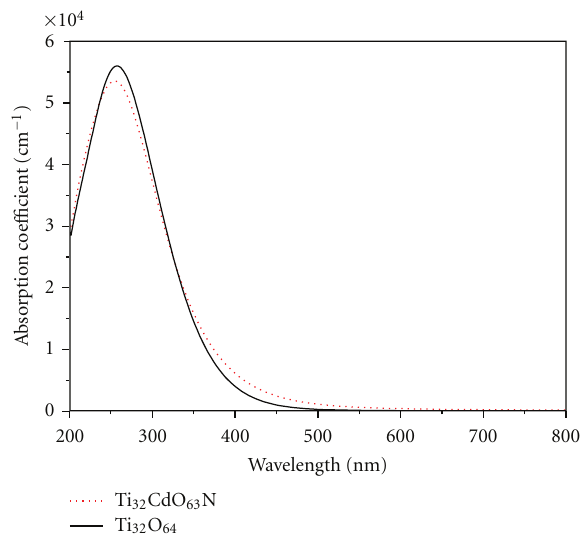
Figure 9: Absorption spectra of the pure and N, Cd-codoped anatase TiO 2